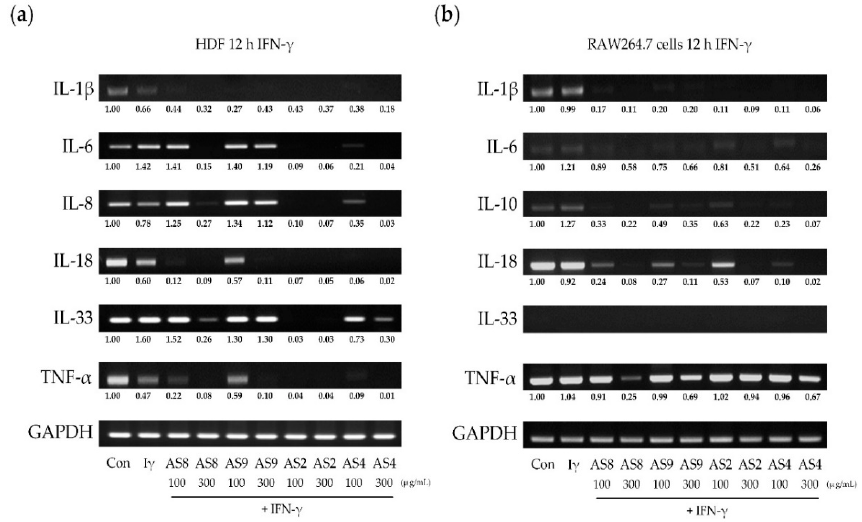
Figure 6. Changes in cytokine expression induced by IFN- γ in ( a ) HDFs and ( b ) RAW 264.7 cells treated with AS extracts.